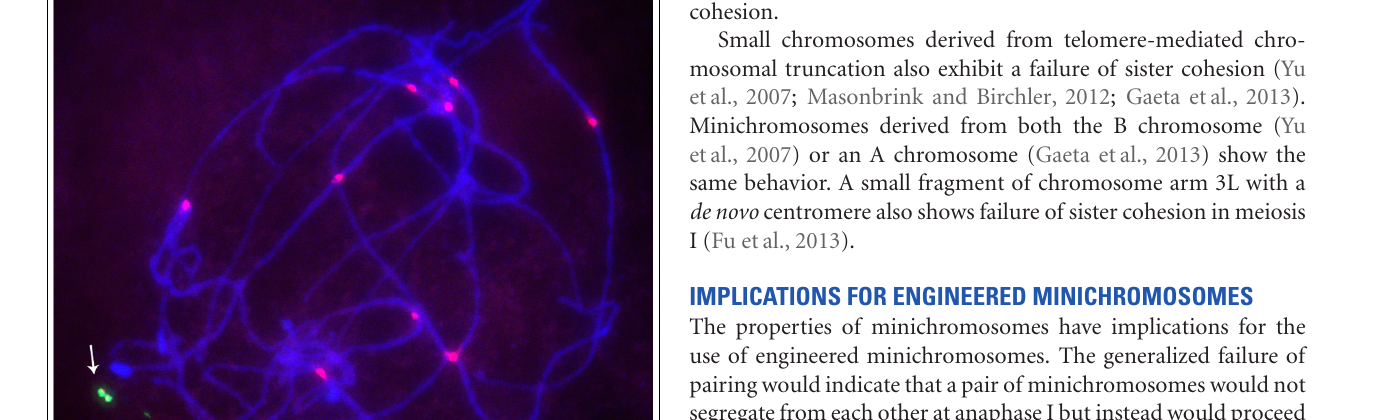
the failure of sister cohesion is not dependent on homologous pairing.